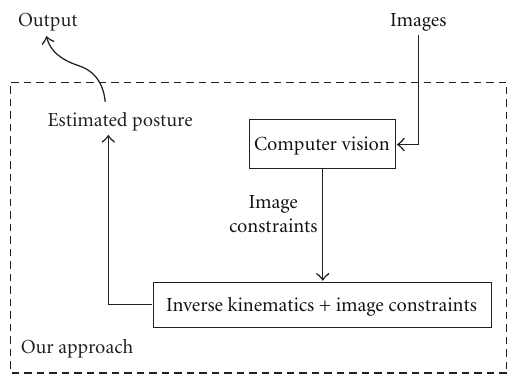
Figure 1: Current approach to combine computer vision and inverse kinematics.